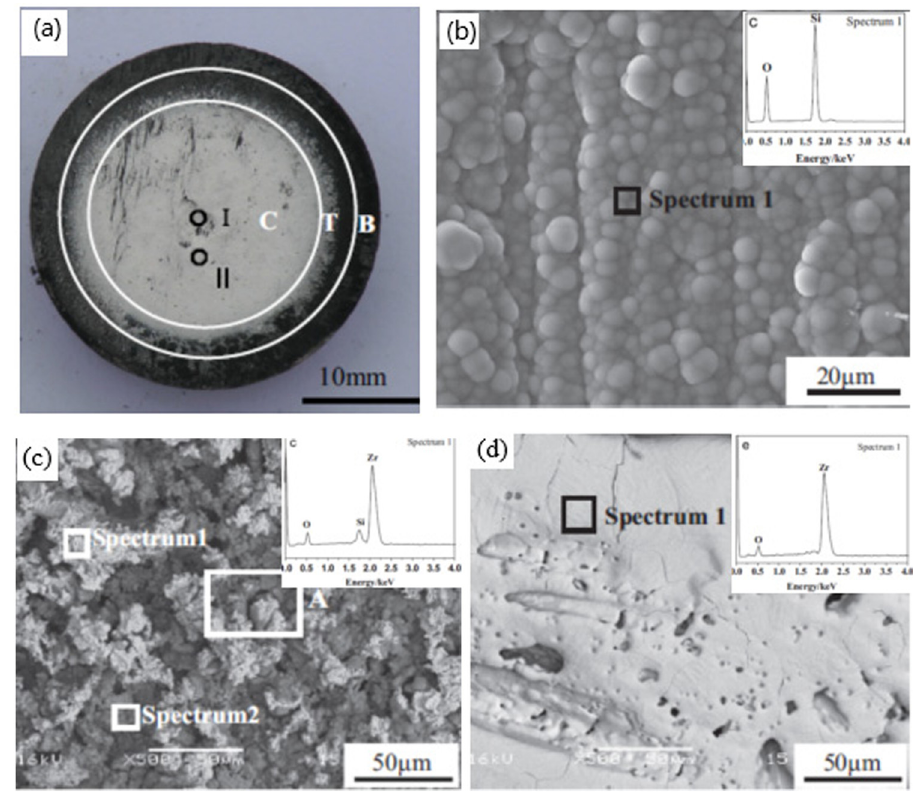
Figure 1: Photo and microstructure images of ablated surface for C/C – SiC – ZrC composite [ 35 ] : ( a ) surface appearance photograph, ( b ) brim ablation region, ( c ) transition ablation region and ( d ) center ablation